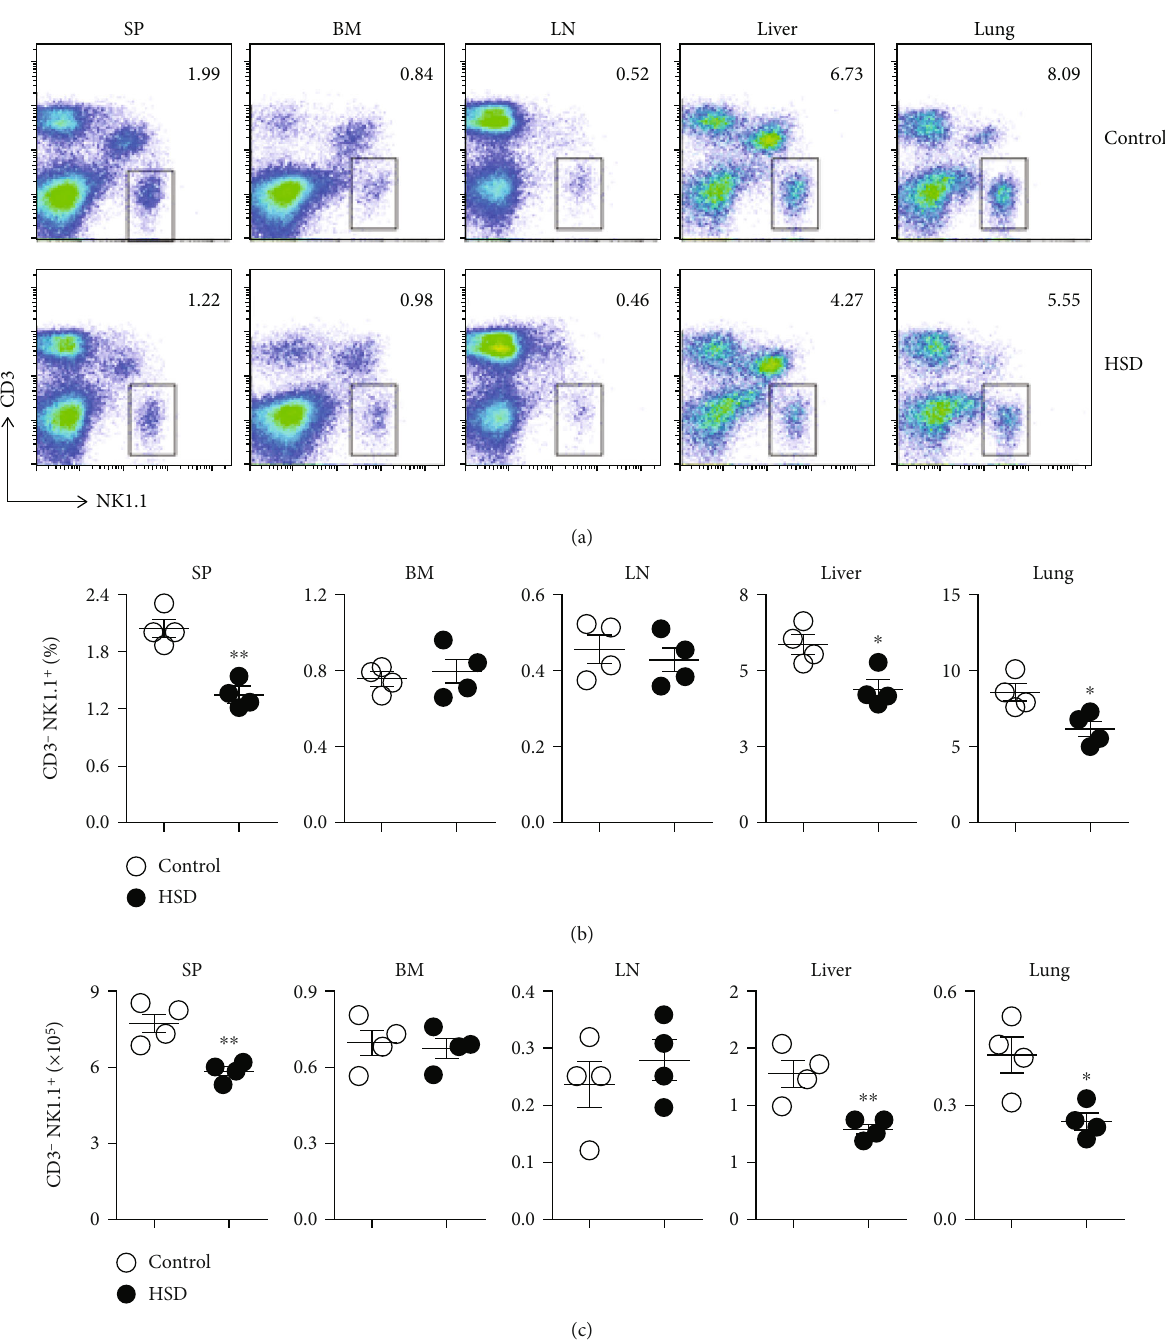
Figure 2: The number of NK cells in the spleen and lungs of HSD-fed mice was decreased. Representative fl ow cytometry pro fi les of CD3 - NK1.1 + NK cells from the spleen (SP), bone marrow (BM), lymph nodes (LN), liver, and lungs of control or HSD-fed mice (a). The percentage of NK cells in the indicated organs and tissues from control and HSD-fed mice (b). The absolute number of NK cells in the indicated organs and tissues from control and HSD-fed mice (c). Each symbol represents an individual mouse. All the data represent at least three independent experiments. Data are shown as the means ± SEM . Unpaired Student ’ s t -tests (two-tailed) were performed using the Prism software. A P value of < 0.05 was considered signi fi cant. ∗ P < 0 : 05 , ∗∗ P < 0 : 01